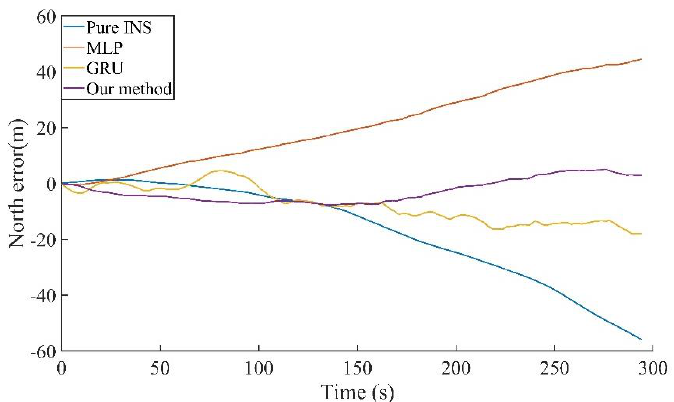
Figure 17. The north position error result of 300 s outage of Experiment 1.